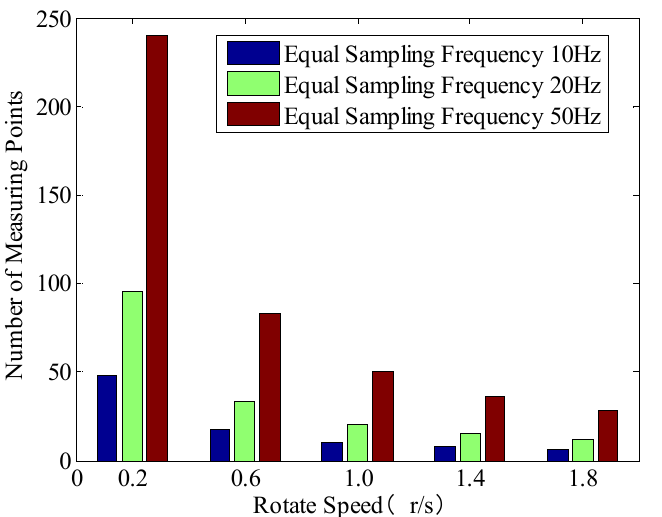
Figure 13. Relationship between speed and number of measurement points—(equal sampling fre- quency). Table 3. Dynamic performance of laser tracker at equal sampling frequency and different speeds (D = 3 m).